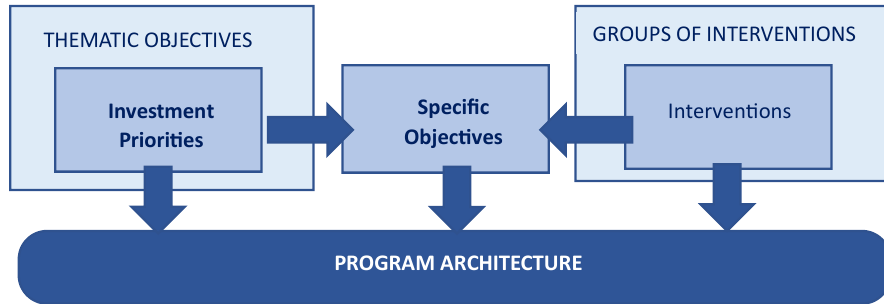
Figure 11. ETC programmes architecture. Source: own study.